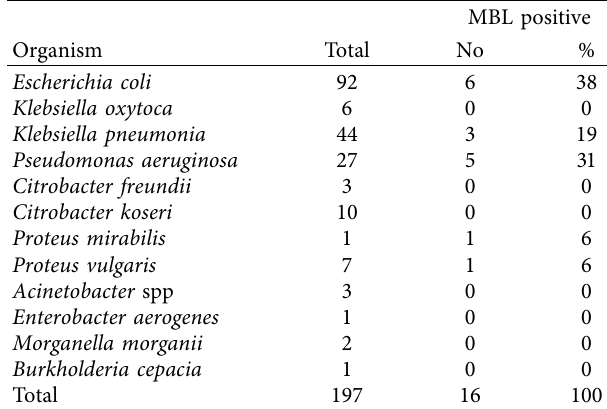
Figure 2: Confirmation of MBL production by combined disc diffusion method in Pseudomonas spp. (A � imipenem and B � imipenem+EDTA). Table 3: MBL production among Gram-negative